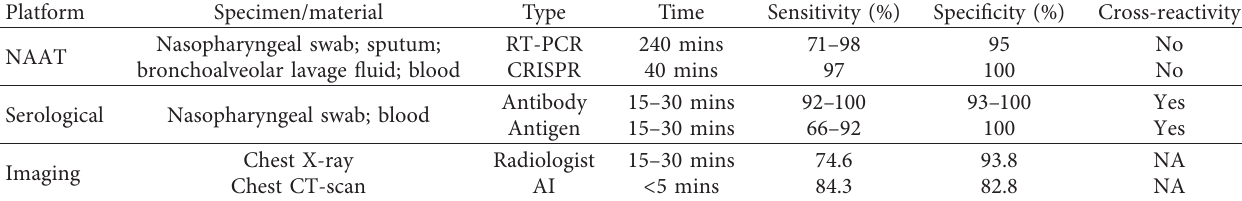
Table 1: A comparison of current diagnostic options for